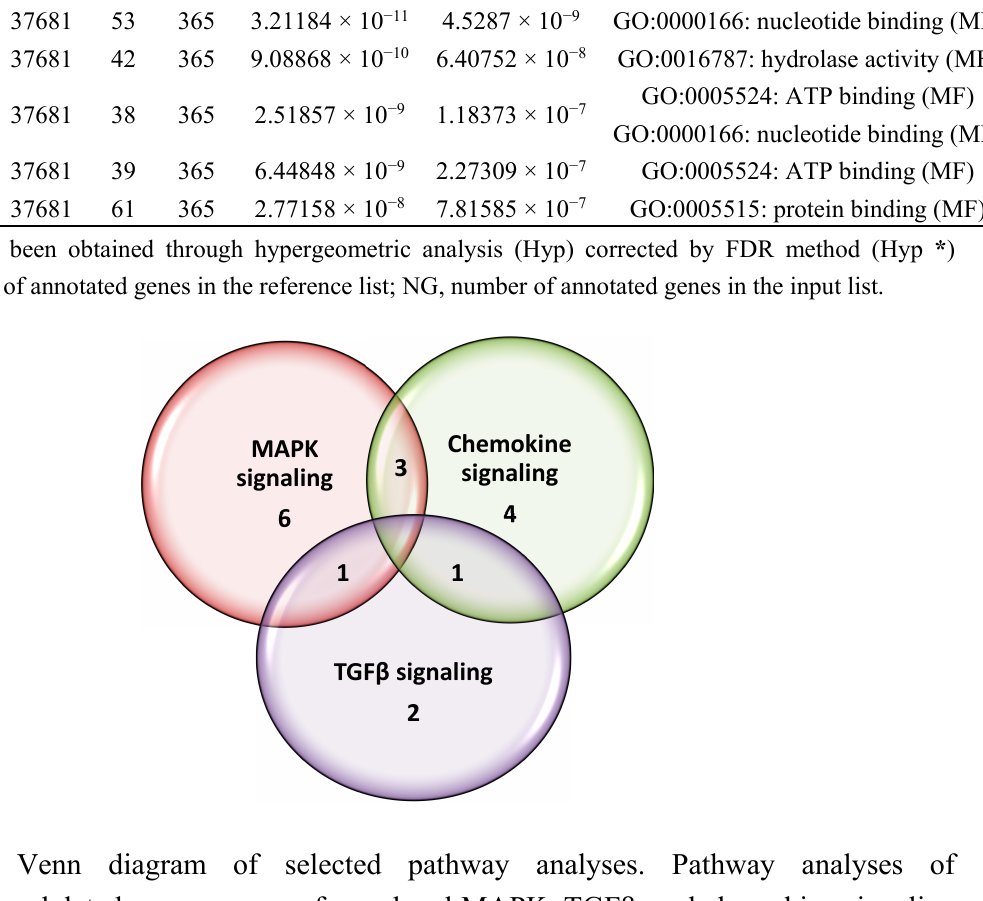
Figure 2. Venn diagram of selected pathway analyses. Pathway analyses of Soyselect ® -modulated genes were performed and MAPK, TGFβ, and chemokine signaling were included as examples.